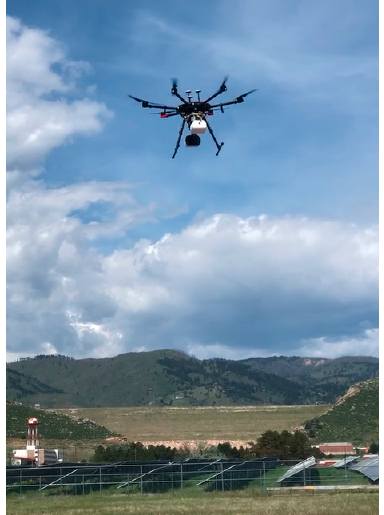
Figure 4. Photograph of sUAS in the air with integrated methane sensor. Sensors 2020 , 20 , x FOR PEER REVIEW